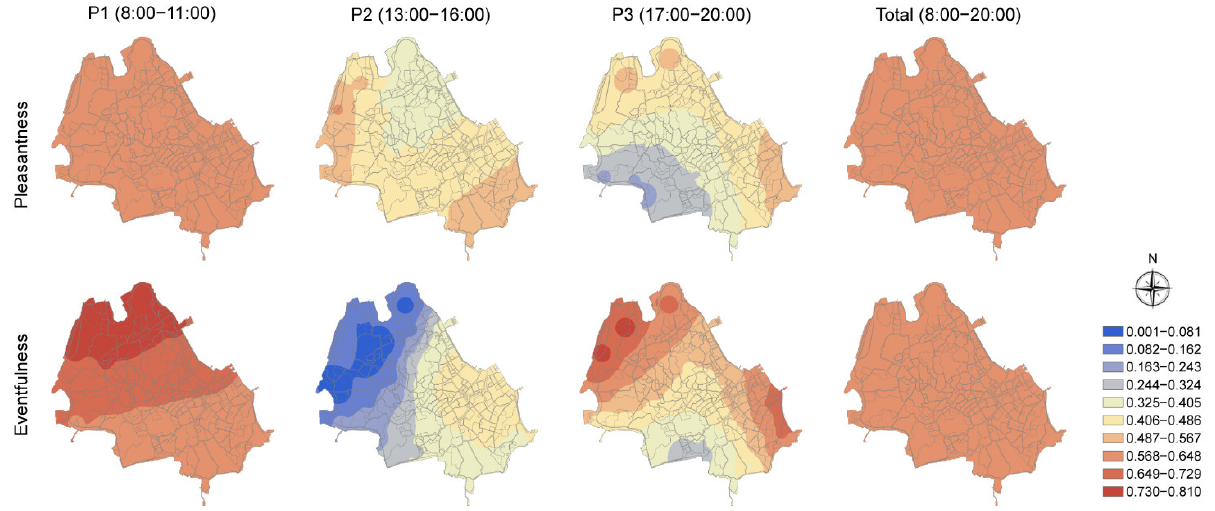
Figure 7. Spatial distribution of local R 2 for pleasantness and eventfulness in the three and total sampling periods.